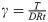
Selection for plasmid transfer through discrimination of recipients.A: Donor ability to self and others among natural isolates. A normalized donor ability for the R1 plasmid for couples of donor and recipient strains was obtained by correcting conjugation rates from [11] (left of the dashed line) and [12] (right of the dashed line) datasets by the average strain donor ability across all recipient strains tested. Points in red indicate donor ability measured from a strain to itself. B: Conjugation rates between E. coli K12 and B strains. Conjugation rates were measured in the same growth conditions as for Fig 2C competitions. Donors and recipients were mixed during exponential growth (optical density [OD] = 0.2), then donor (D), recipient (R), and transconjugant (T) densities were measured by plating. Conjugation rates were computed as γ=TDRt (mL.cell-1.h_1), and are shown as geometric means ± standard error of the mean (SEM) (N ≥10). Red bars show conjugation data obtained with the wild type K12 strain, grey bars show conjugation using the K12ΔarcA mutant. C: Competition between K12 and B strains with antibiotic resistance transfer. The change in frequency of K12 strain is shown in competition with B strain in a single well-mixed population, in the absence (blue) or presence (yellow) of antibiotic selection at the end of competition, and for different initial proportions of the R1-19 plasmid, common to both strains. Pale colours show the outcome of competition with the K12ΔarcA strain. Results are shown as means ± SEM (N ≥10). Data are available from FigShare at http://dx.doi.org/10.6084/m9.figshare.3199252.